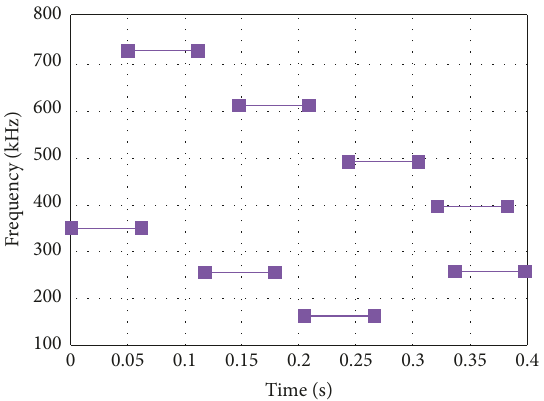
Figure 3: Schematic diagram of a single trombone timbre fre- quency